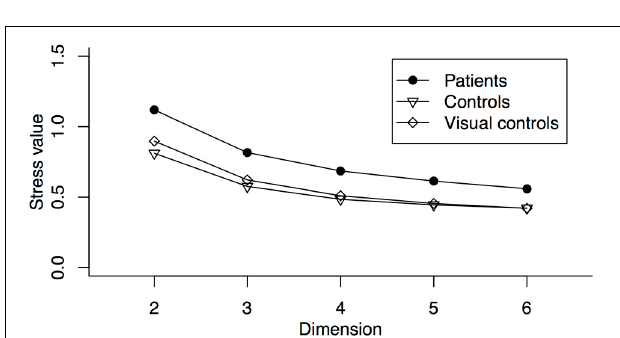
FIGURE 3 | Stress values for 2- to 6-dimensional solutions for the patients and the controls.